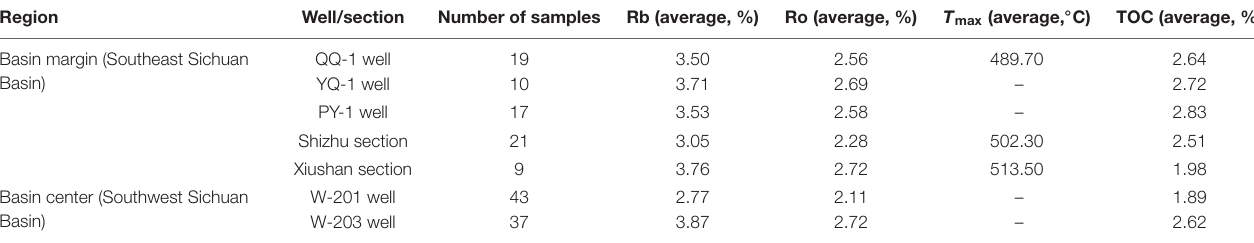
TABLE 1 | Organic geochemial parameters of the Longmaxi Formation shale in the Sichuan Basin. Region